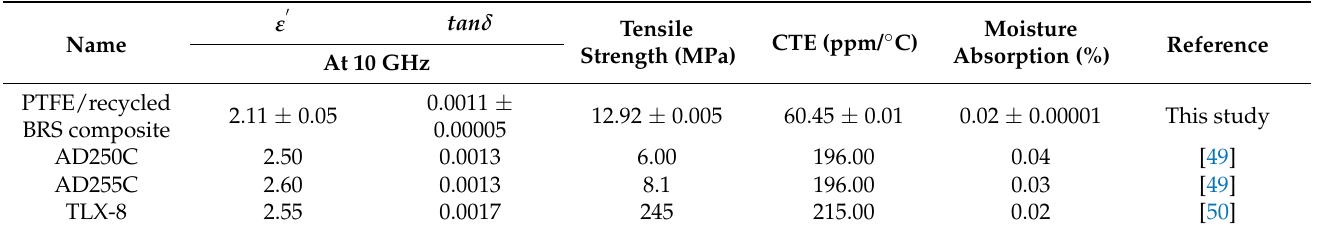
Table 3. Comparison between PTFE/recycled BRS composite and commercial high-frequency